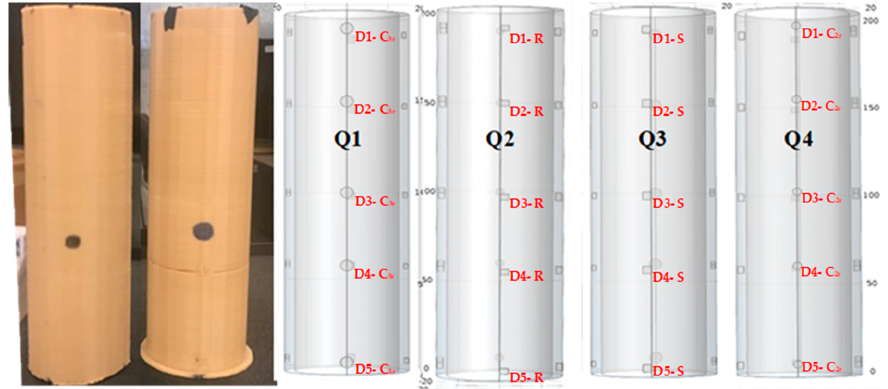
Figure 2. The 3D-printed coupons for the cylinder samples and the COMSOL ® model with the four di ff erent quadrants. Table 1. Descriptions of the 20 di ff erent defects employed to test the impact of varying factors on IRT